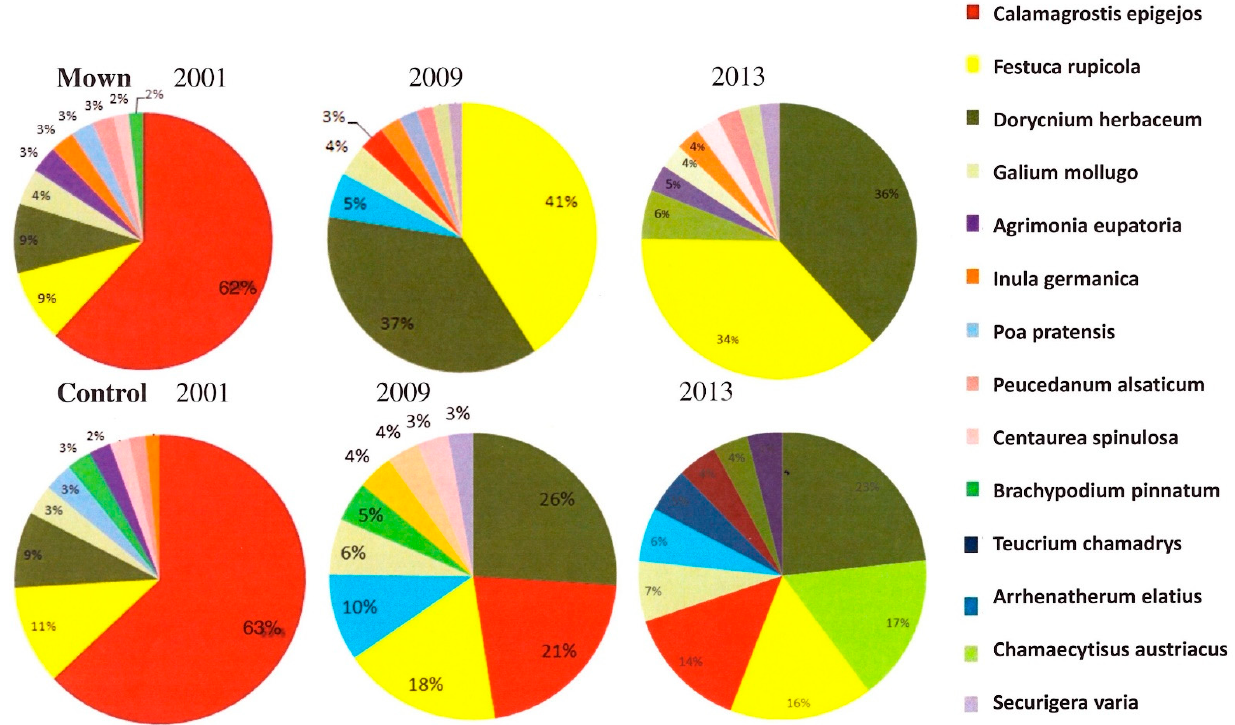
Figure 4. Changes in the relative cover proportion of the most dominant species during vegetation development.